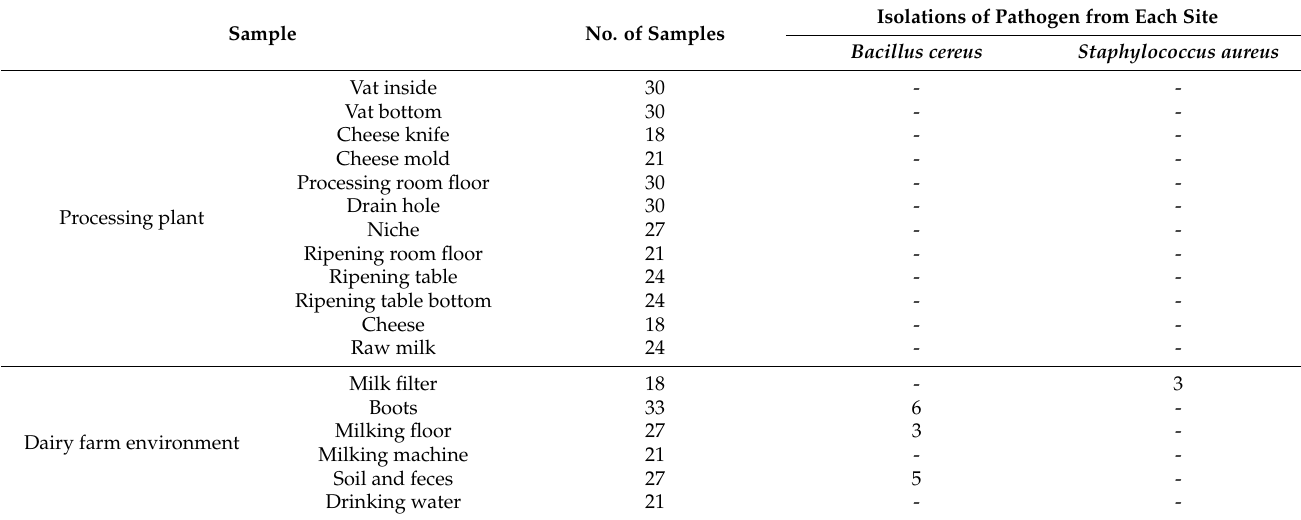
Table 10. Prevalence of B. cereus and S. aureus on each sample type.